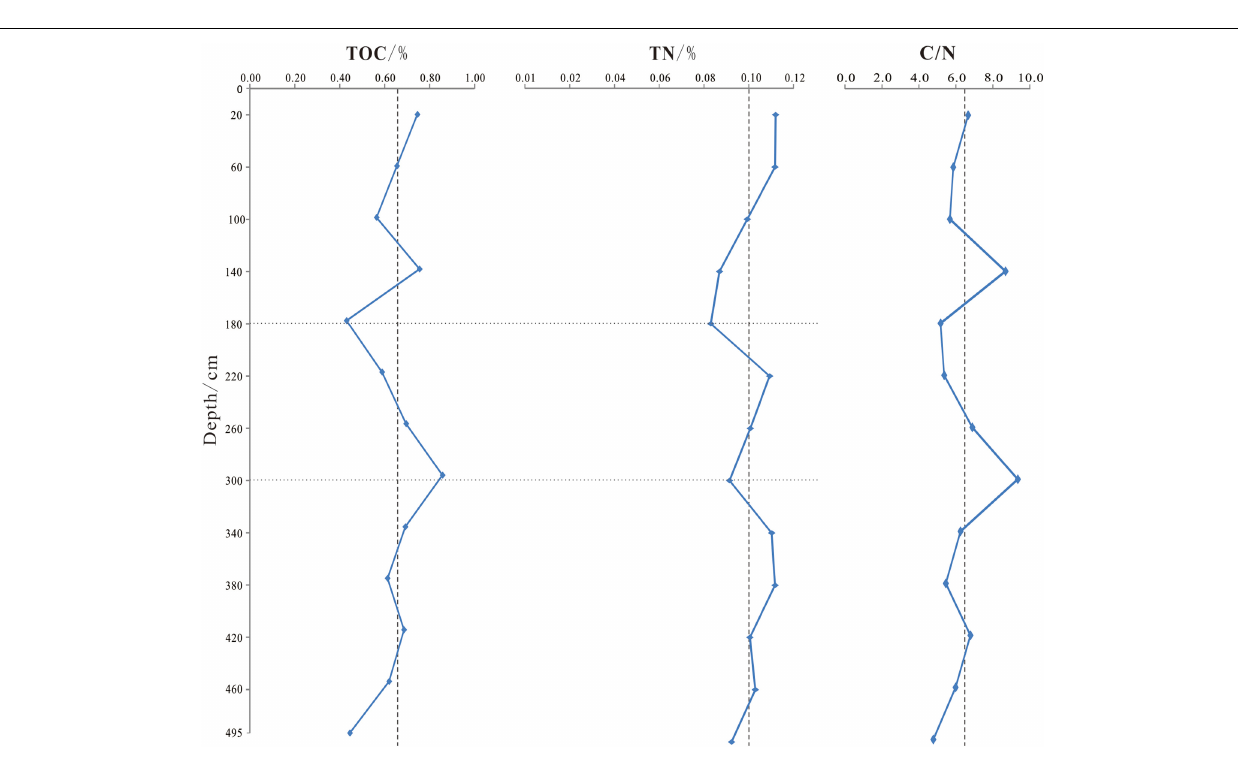
FIGURE 3 | Vertical profiles of TOC, TN, and C/N in core sediment